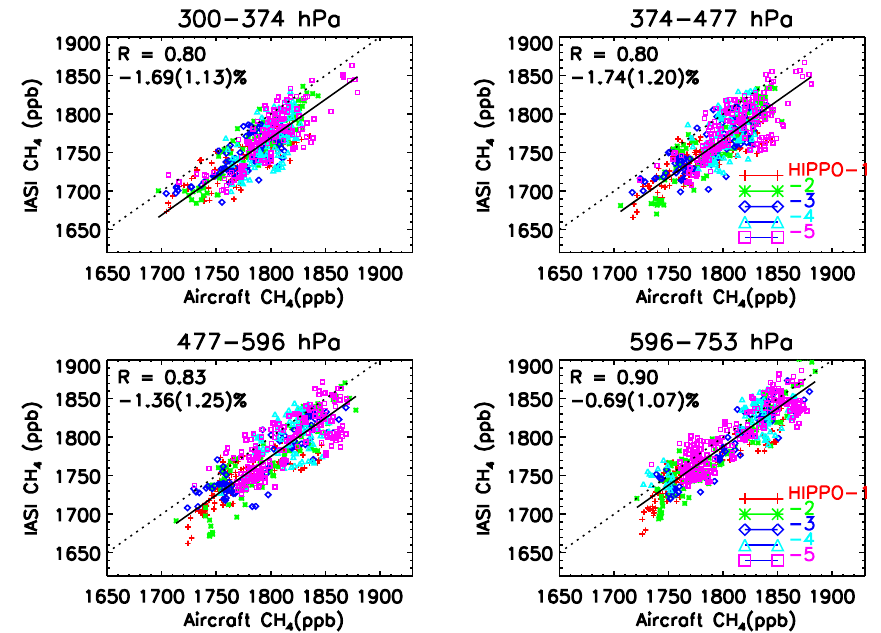
Fig. 8. IASI-retrieved CH 4 mixing ratios plotted against aircraft profiles from HIPPO-1, -2, -3, -4 and -5 in four trapezoid layers of 300–374, 374–477, 477–596 and 596–753hPa. The x axis is the convolved aircraft measurements, and the y axis is the mean of IASI-retrieved profiles within 200km and on the same day of the measurement time and site location. Different colors are from different campaigns of HIPPO. R is the correlation coefficient, and the numbers below are the bias and residual standard deviation, respectively, in percent.